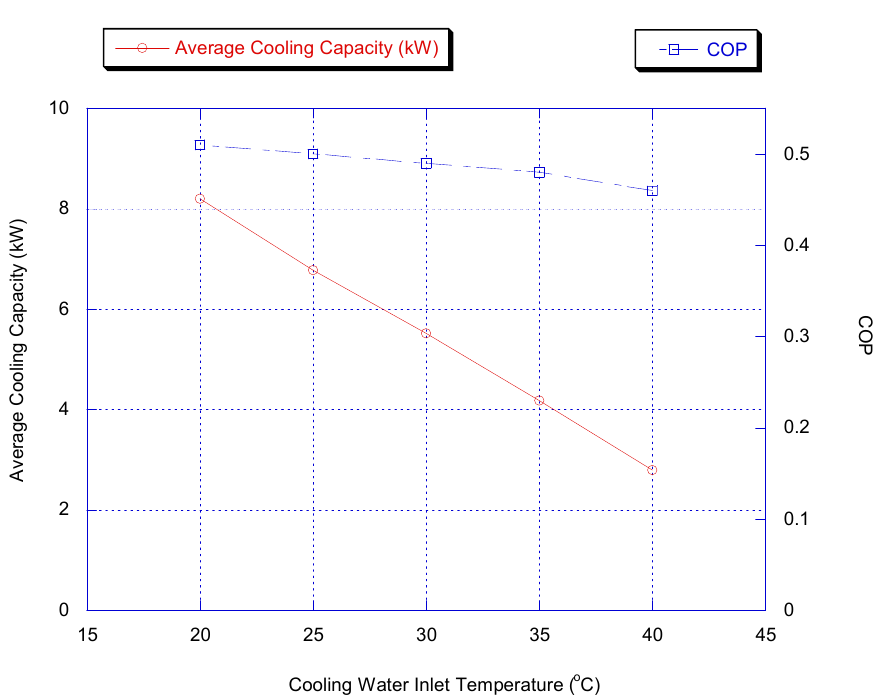
Figure 13. Effect of cooling water inlet temperature on chiller average cooling capacity and COP heat recovery (results are at optimum parametric values, shown in Appendix B). with heat recovery (results are at optimum parametric values, shown in Appendix B).